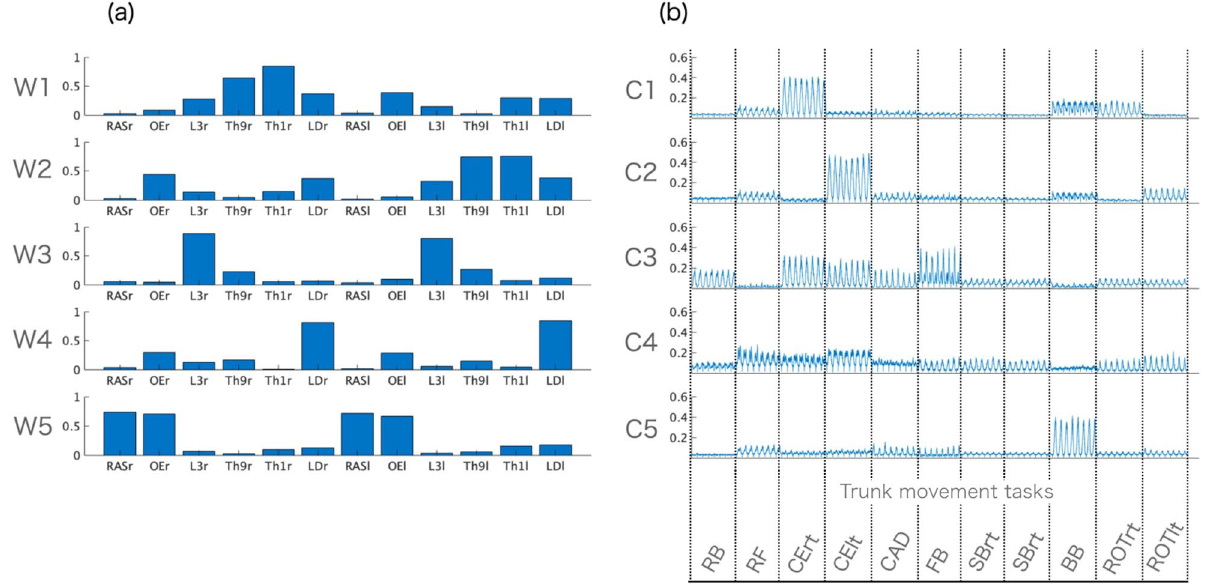
Figure 5. Representative ( a ) five-trunk muscle synergies (W1–W5) and ( b ) their temporal patterns (C1–C5). Non-negative matrix factorization on the concatenated electromyography (EMG) envelopes of 11 trunk motor tasks extracted five trunk muscle synergies for each participant. We sorted the trunk muscle synergies of all participants into five groups using hierarchical cluster analysis.